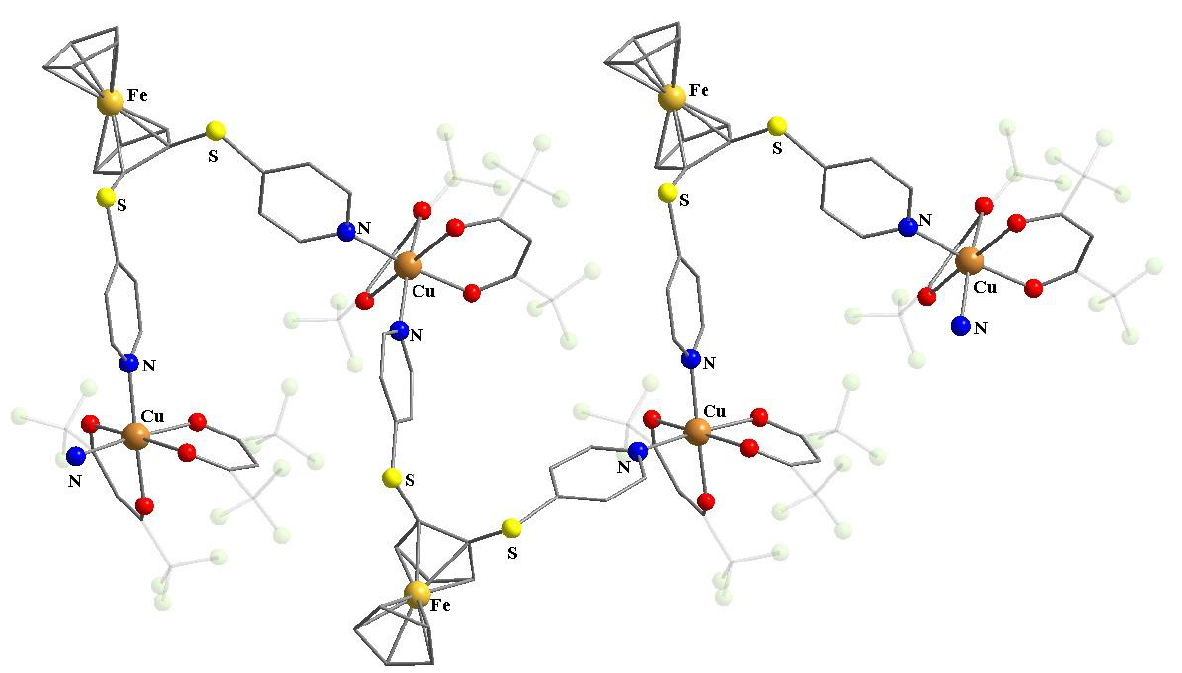
Figure 26. A fragment of polymeric structure of 51 [95]. Hydrogen atoms have been omitted, some ligand groups are transparent for clarity. The cif has been retrieved from CCDC. CCDC number is 1556476.